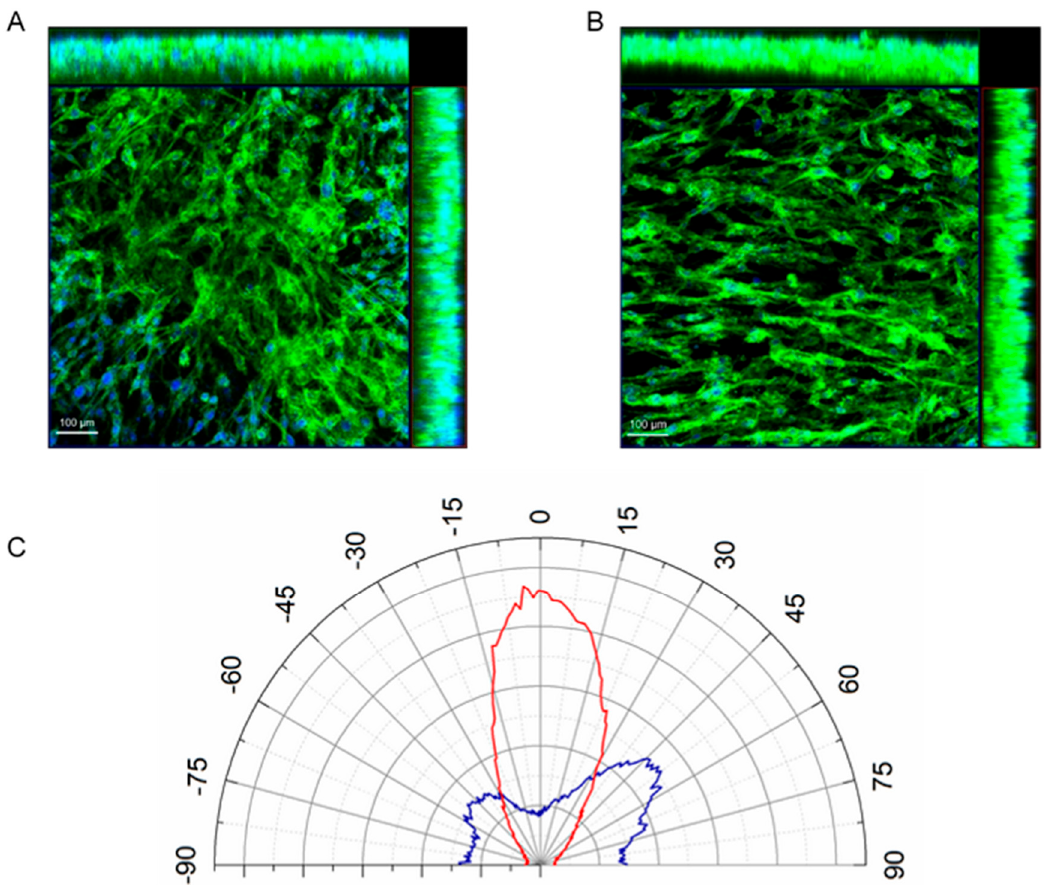
Figure 3. Morphology of SH-SY5Y cells in a random collagen hydrogel scaffold ( A ) and in an aligned m-rGO/collagen composite hydrogel ( B ). ( C ) Angular distribution of randomly oriented (blue trace) and aligned SH-SY5Y cells (red trace).